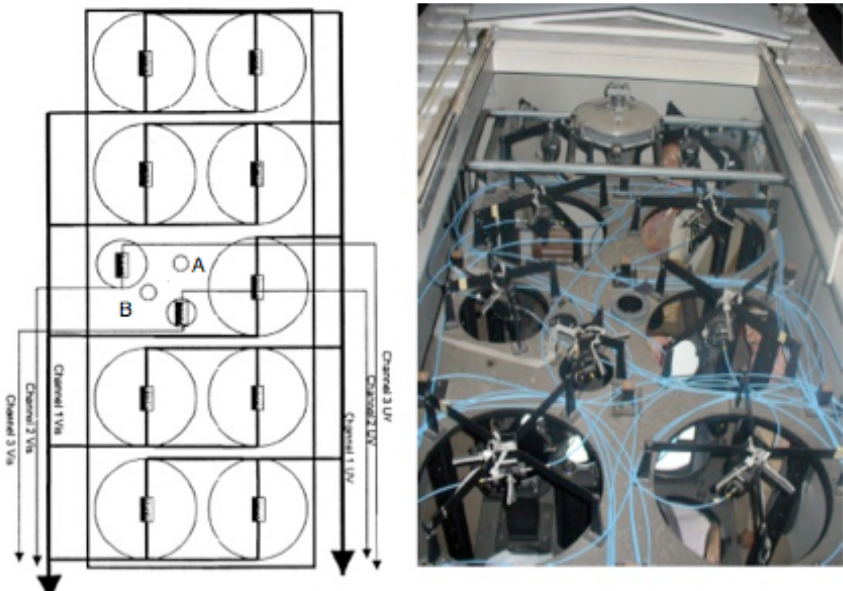
Fig. 1. Diagram of the RMR receiving channels (left) with their corresponding bird’s eye view (right). A and B in the diagram (left) are the exit holes for the upward laser beam at 532 and 355nm, respectively. Figure 1. Diagram of the RMR receiving channels (left) with their corresponding bird’eye view (right). A and B on the diagram are the exit holes for the upward laser beam at 532 and 355 nm, respectively.